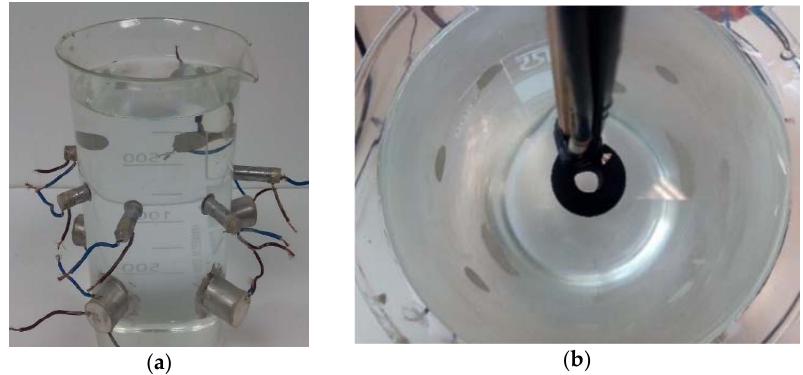
Figure 7. Configuration 2: measurements in a testing vessel. ( a ) Image of the vessel with all ceramics attached; ( b ) calibration with an FFR SX30 reference transducer. The scheme of the experimental setup is the same than in configuration 1.